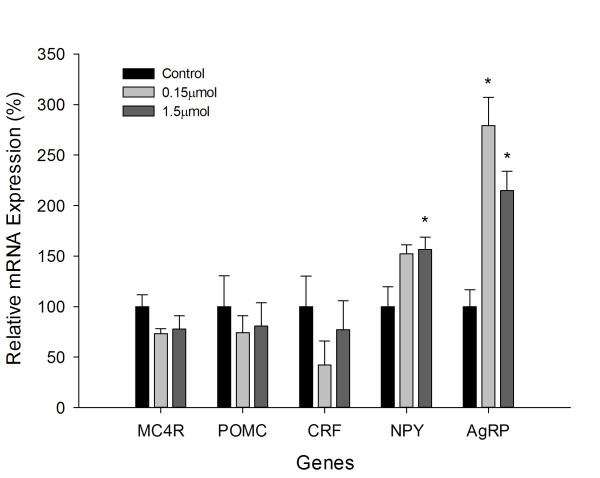
Relative mRNA expression levels for hypothalamic MC4R, POMC, CRF, NPY and AgRP 2 h after ICV injection of leucine; Data are represented as means ± S.E.M. (n = 6). Asterisk indicates significant difference from control group within each time point (P < 0.05).